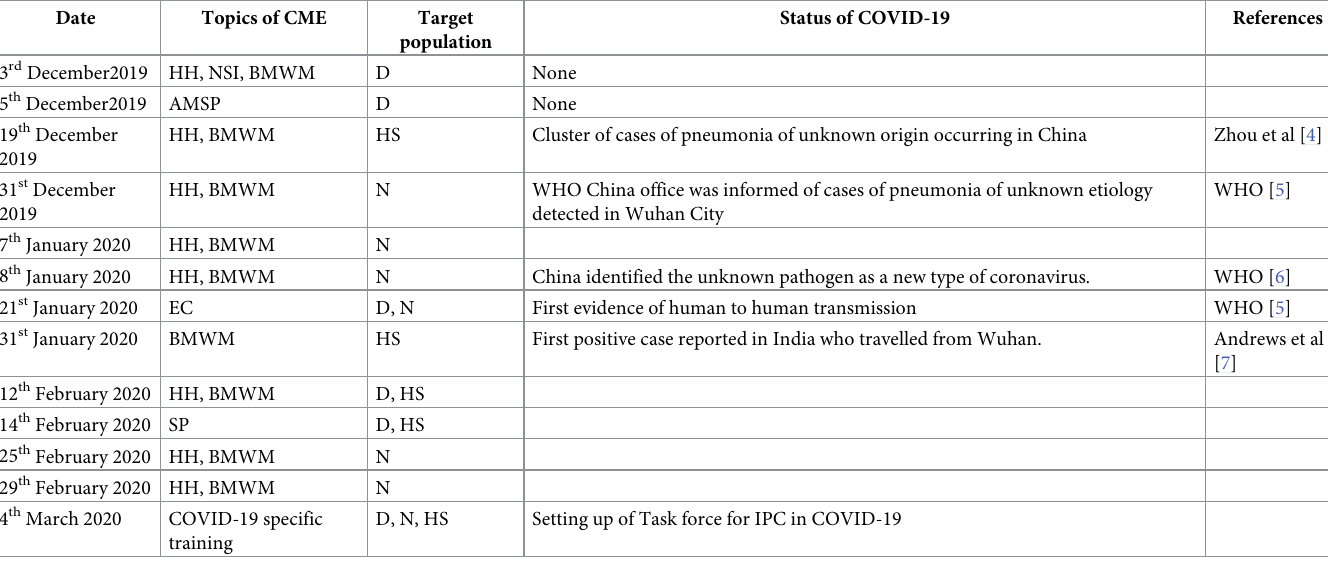
Table 1. Timeline of the IPC training activities in the study centre at the beginning of the COVID-19